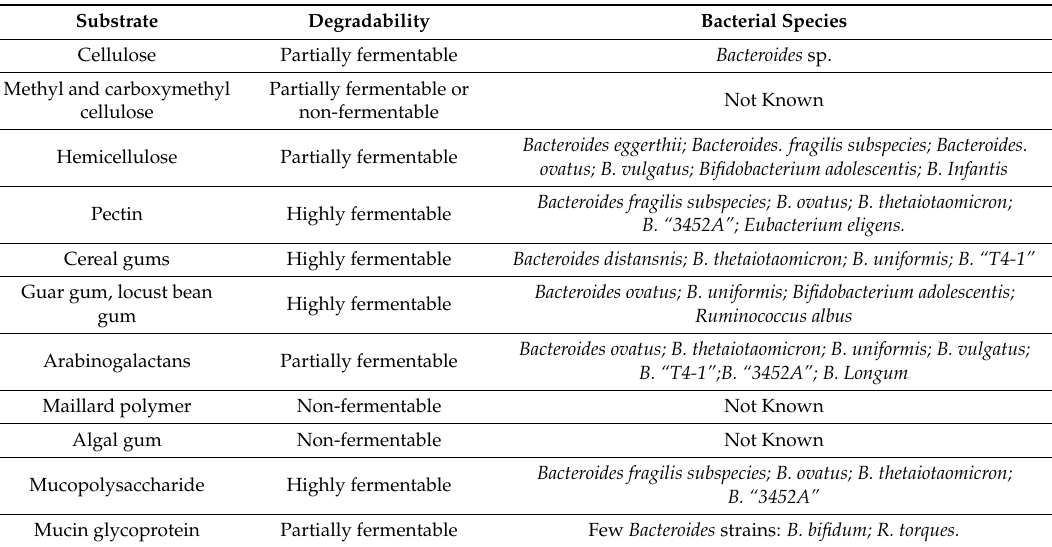
Table 1. Some of the predominant anaerobic bacterial species found in the human intestine and studied in pure cultures with selected carbohydrates [116], slightly